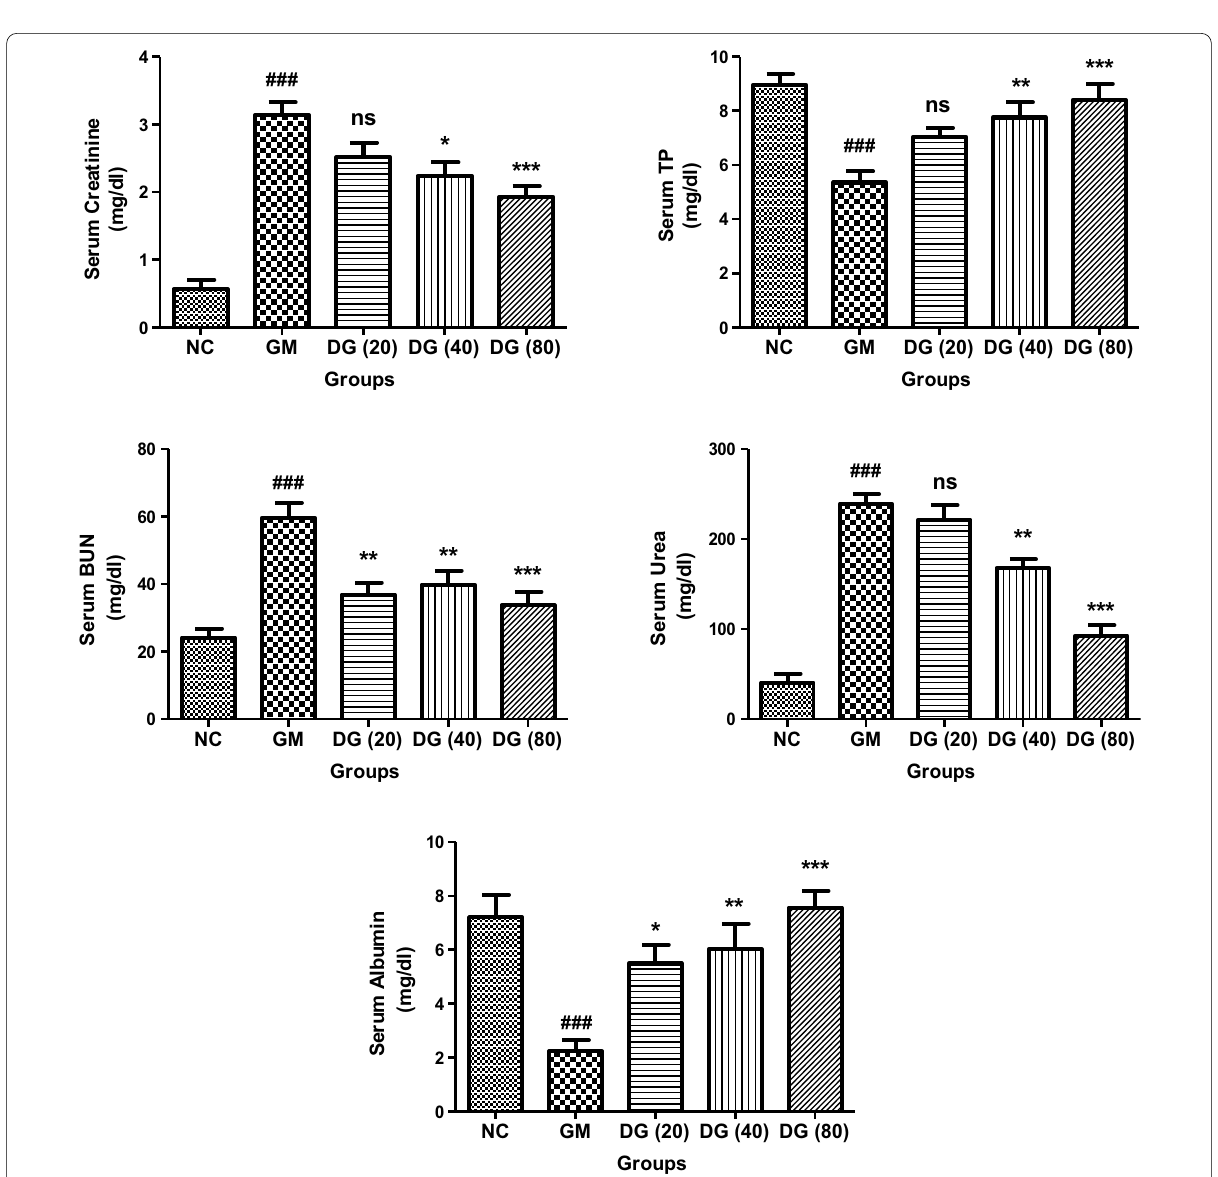
Fig. 3 Effect of DG on serum Cr, TP, BUN, urea and albumin (mg/dl) in GM induced renal damage in rats. Results are expressed as Mean (n 6). ### p < 0.001 as compared to NC rats and * p < 0.05, *** p < 0.01, *** p < 0.001 compared to GM =